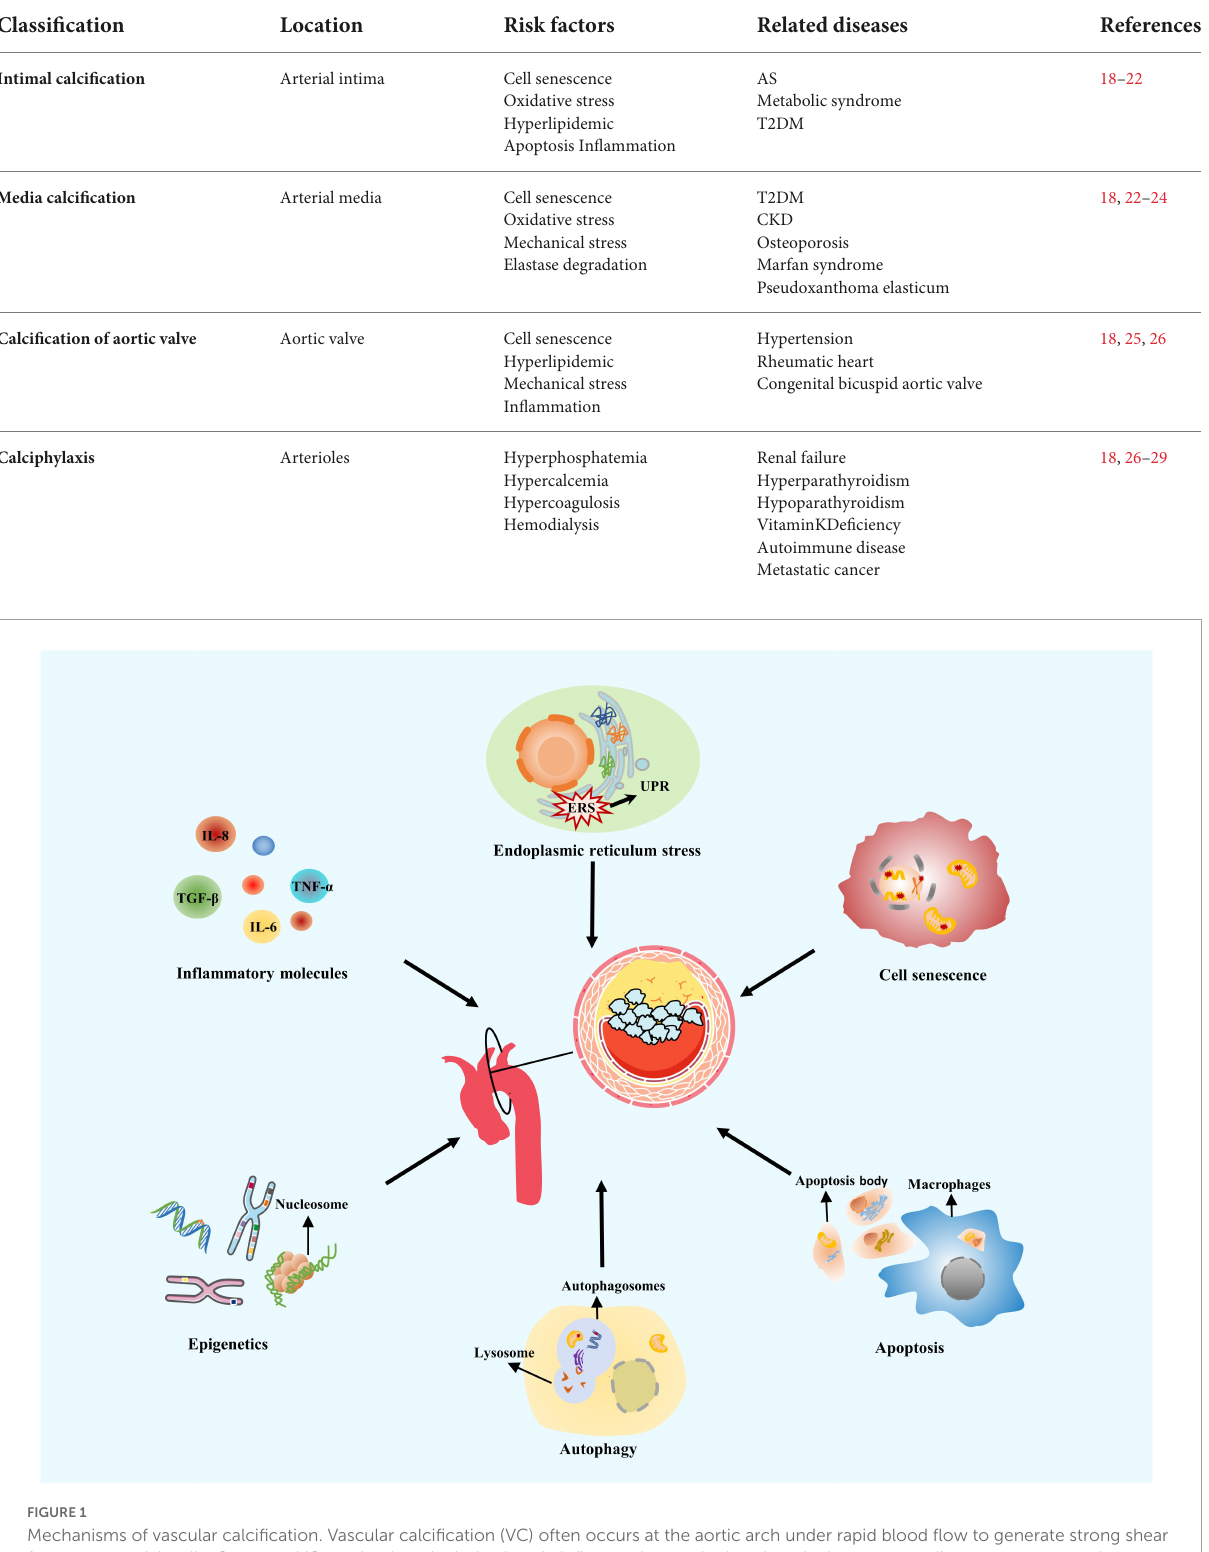
TABLE 1 Classification of vascular calcification.